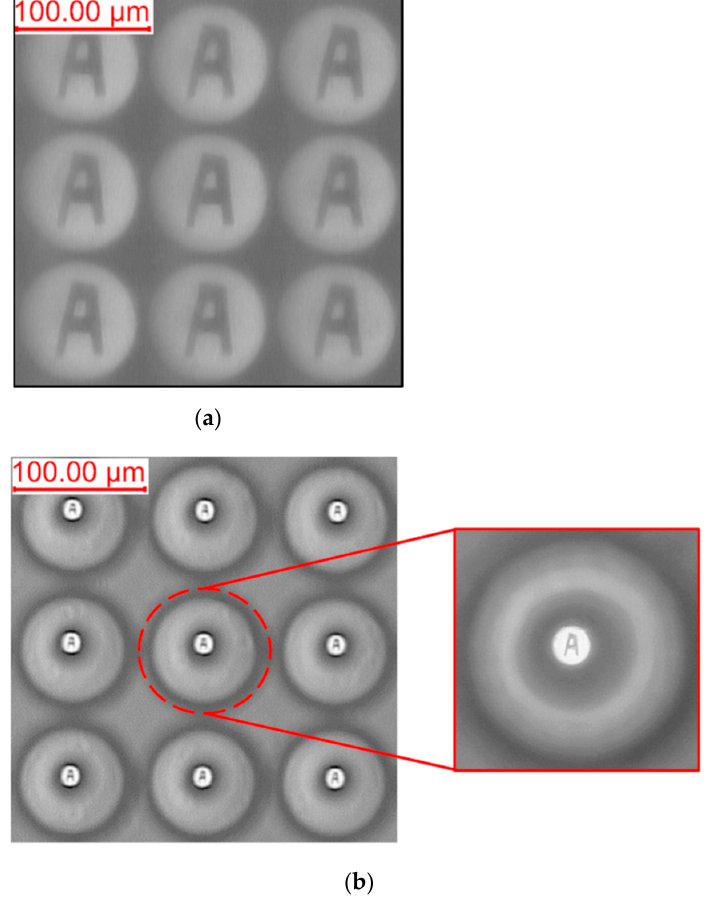
Figure 9. The focusing and imaging abilities of the MLLA. ( a ) Images obtained in the focal plane of the lower-layer microlenses. ( b ) Images obtained in the focal plane of the upper-layer microlenses.